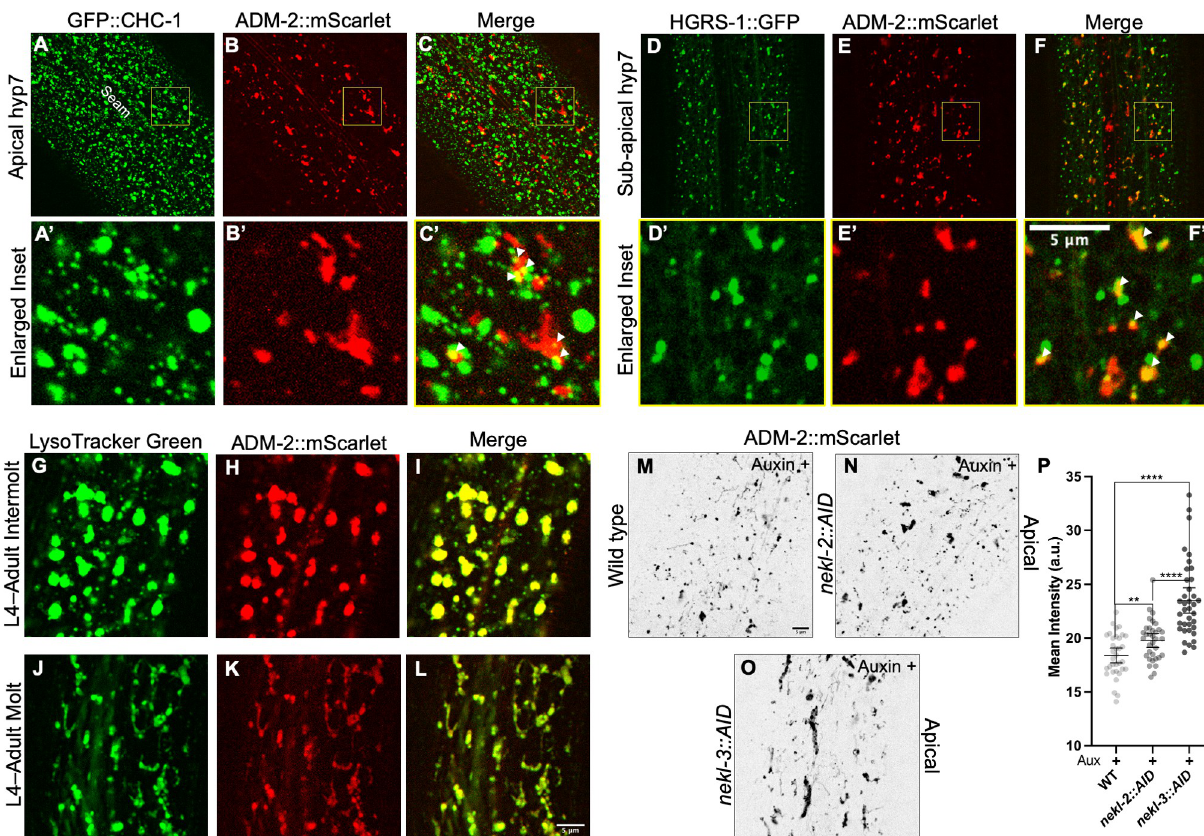
Fig 3. ADM-2 localization to endocytic compartments is affected by NEKLs. (A–L) Co-localization analysis of ADM-2::mScarlet with GFP::CHC-1 (A–C), P hyp7 ::HGRS-1::GFP (D–F), and LysoTracker Green (G–L) within apical (A–C) and sub-apical or medial (D–L) planes of hyp7. A’–F’ are insets of A–F confocal images. White arrowheads in C’ and F’ indicate colocalized puncta. For LysoTracker studies (G–L), representative confocal images during intermolt (G–I) and molting (J–L) stages are shown. (M–P) Apical hyp7 ADM-2::mScarlet localization in auxin-treated wild-type (M), nekl-2 :: AID (N), and nekl-3 :: AID (O) 2-day-old adults with average mean intensity calculations (P). Group means along with 95% confidence intervals (error bars) are indicated. p-Values were obtained by comparing means using an unpaired t-test: ���� p � 0.0001, �� p � 0.01. Bar in M = 5 μ m (for A–F and M–O); in F’ = 5 μ m (for insets A’–F’); in L = 5 μ m (for G–L). Raw data for this figure is provided in S1